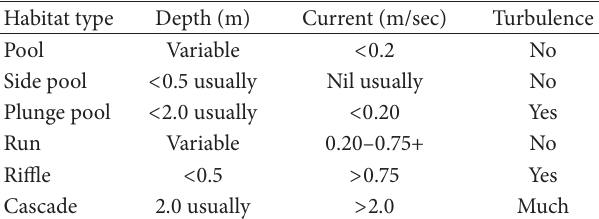
Table 1: Habitat types of fresh water streams